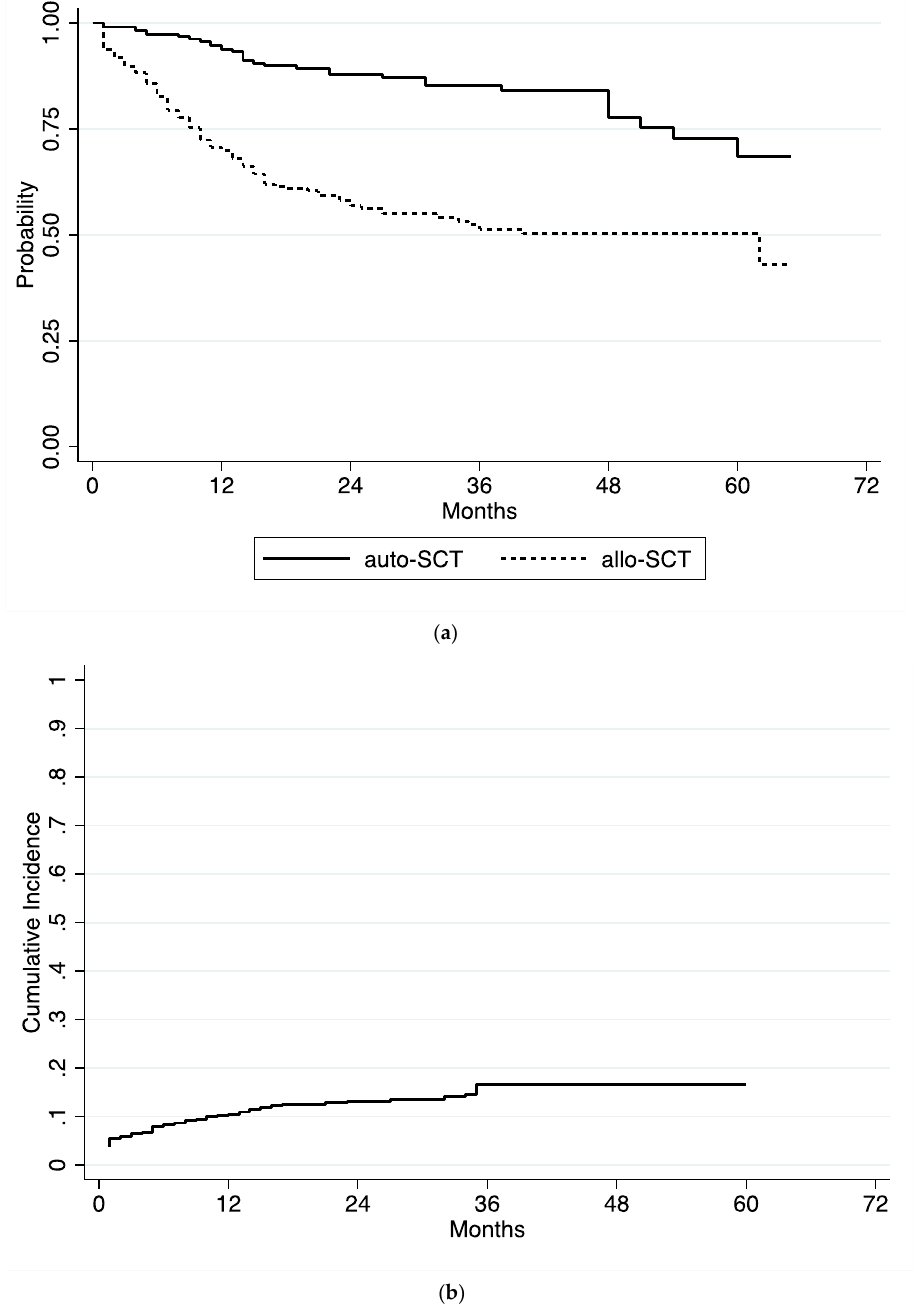
Figure 3. ( a ) Overall survival according to procedure; ( b ) Transplant-related mortality in all study population.